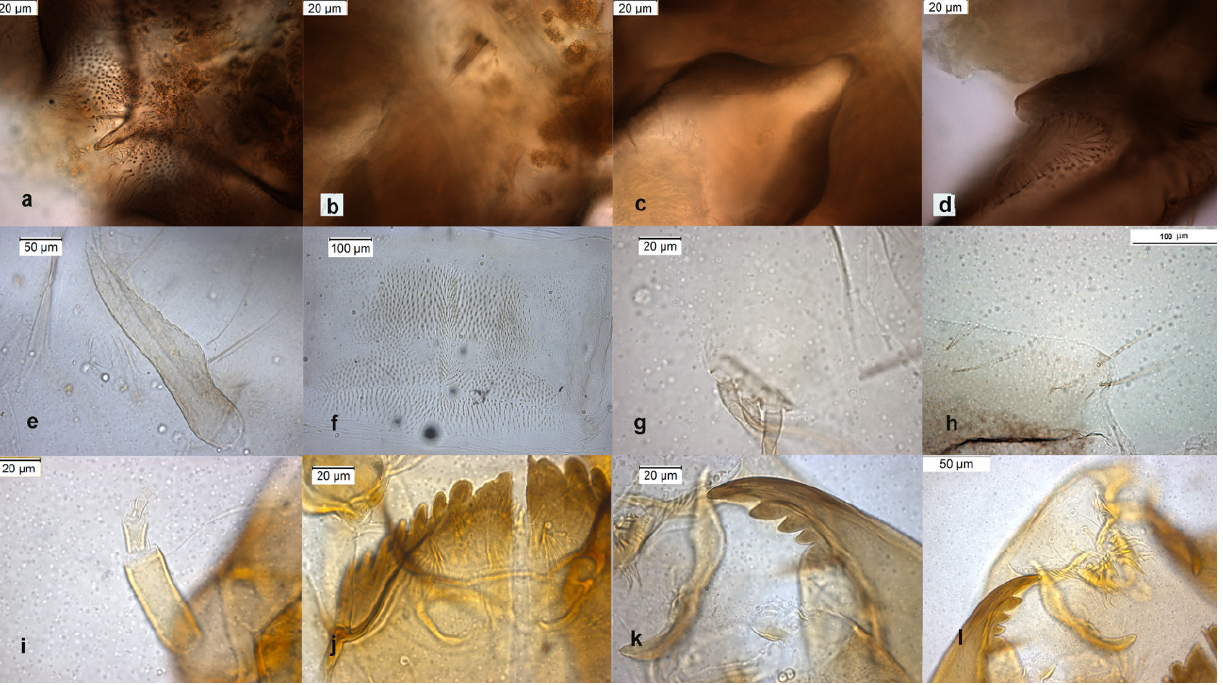
Figure 9. Morphological characters of O. wetterensis adult male: ( a ) anal point; ( b ) virga; ( c ) superior volsella; ( d ) inferior volsella; pupal exuviae: ( e ) thoracic horn, ( f ) tergite IV; ( g ) taeniate extensions; ( h ) TVIII; larva: ( i ) antenna; ( j ) mentum; ( k ) mandible; ( l )